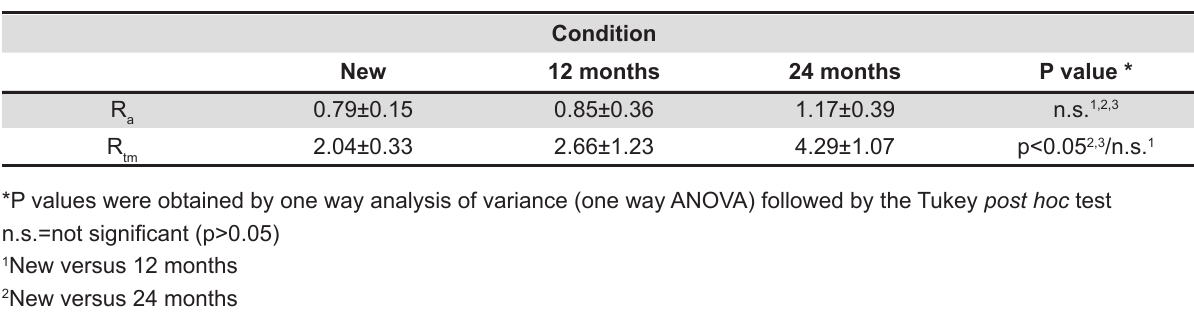
) and of the largest distance between peaks and valleys a